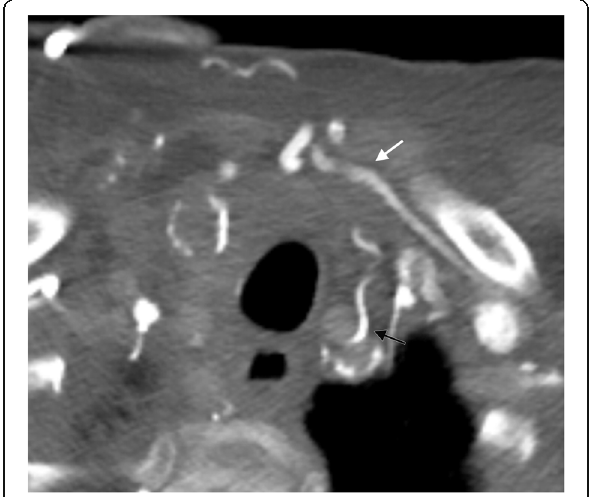
Fig. 7 Anterior neck collaterals. Axial CT image showing the jugular venous arch (white arrow) assisting in the diversion of blood flow to the patent contralateral side and an enlarged inferior thyroid vein collateral (black arrow) in a patient with an obstructed internal jugular